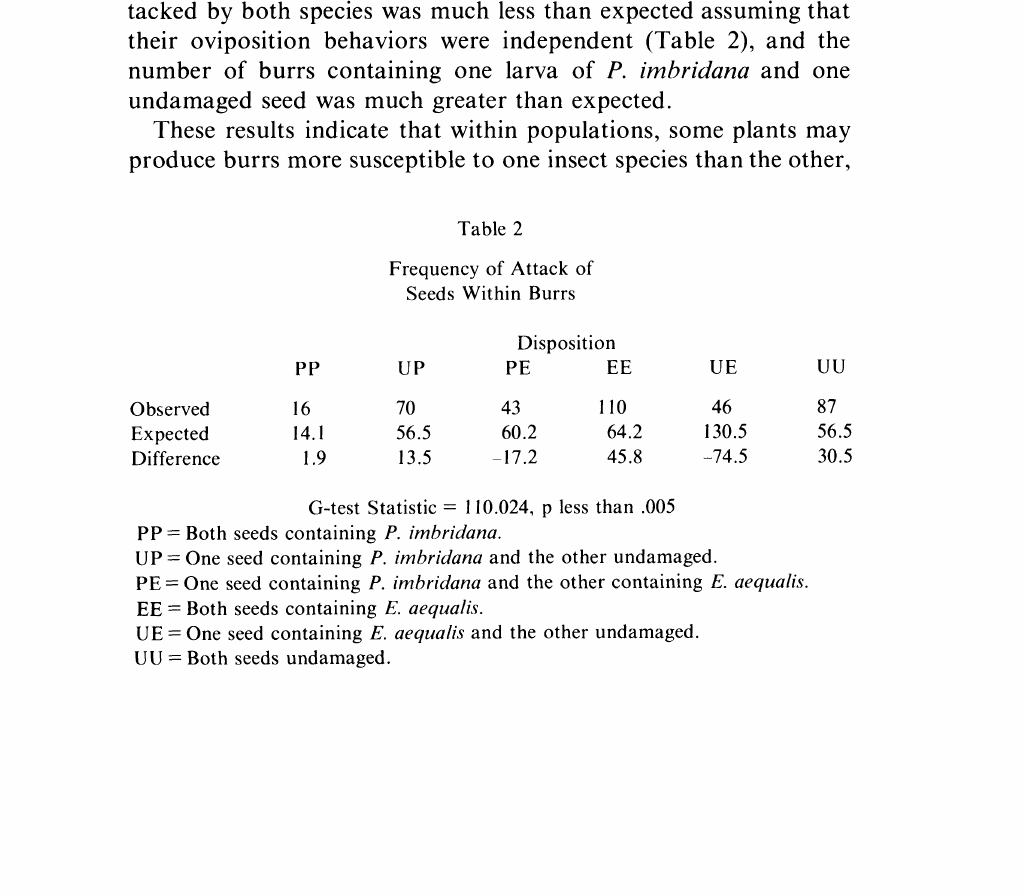
Frequency of Attack of Seeds Within Burrs